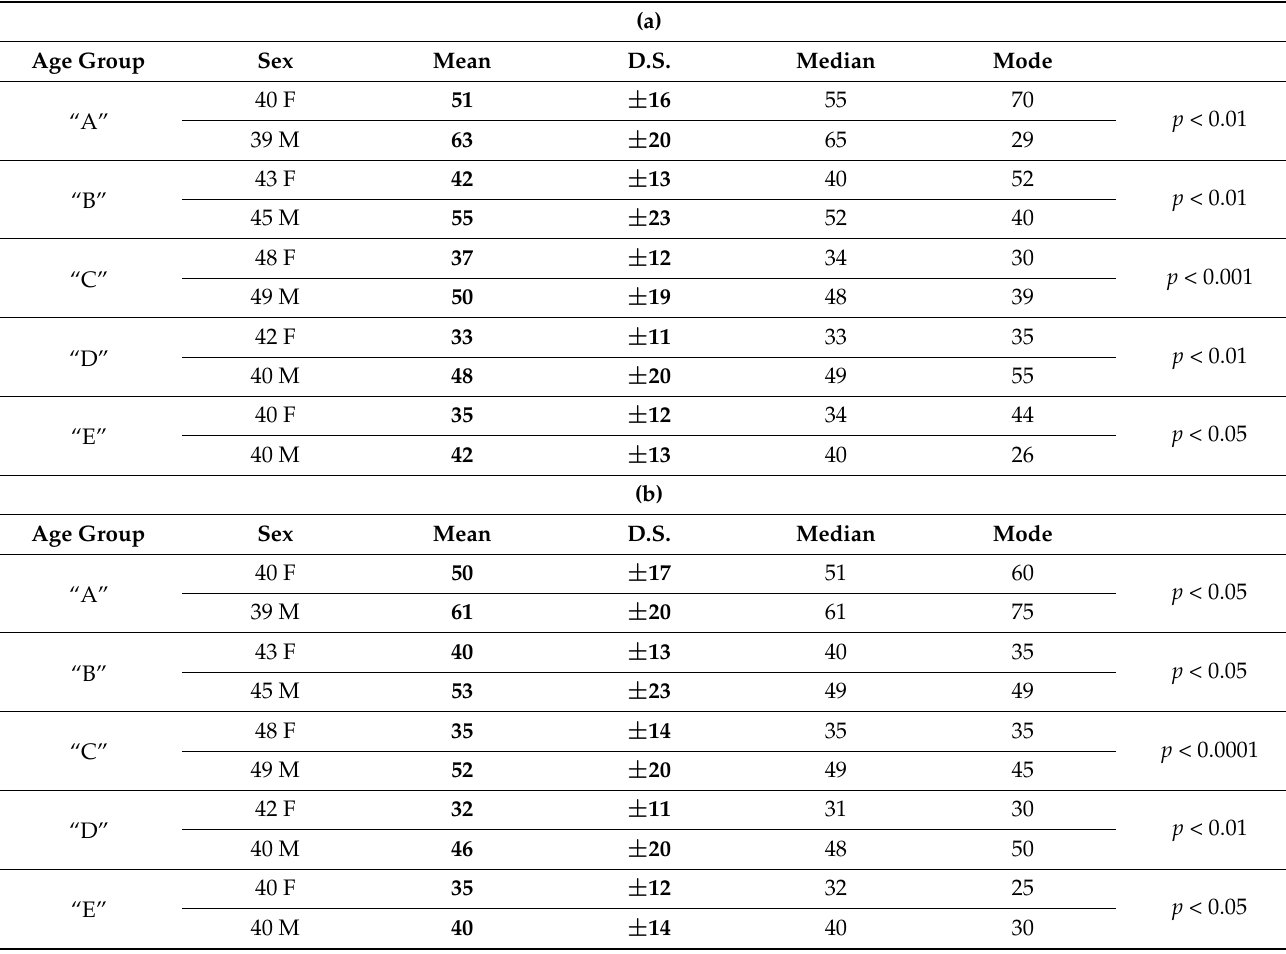
Table 2. ( a ) Right side MBF measures (kg) stratified by sex and age. ( b ) Left side MBF measures (kg) stratified by sex and